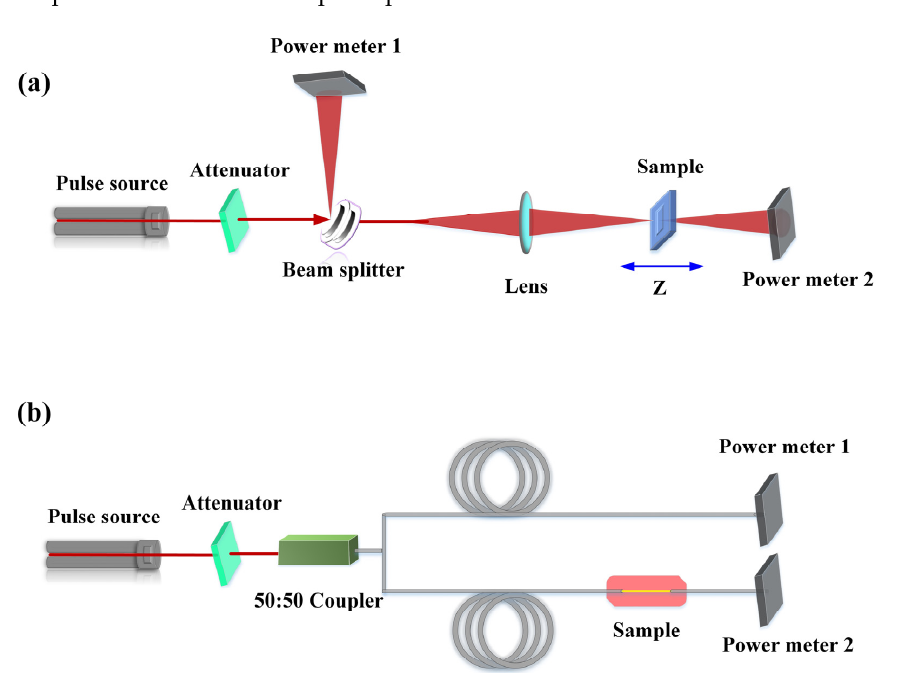
Figure 3. ( a ) Schematic of the Z-scan measurement setup. ( b ) Schematic of the two-arm measurement setup.